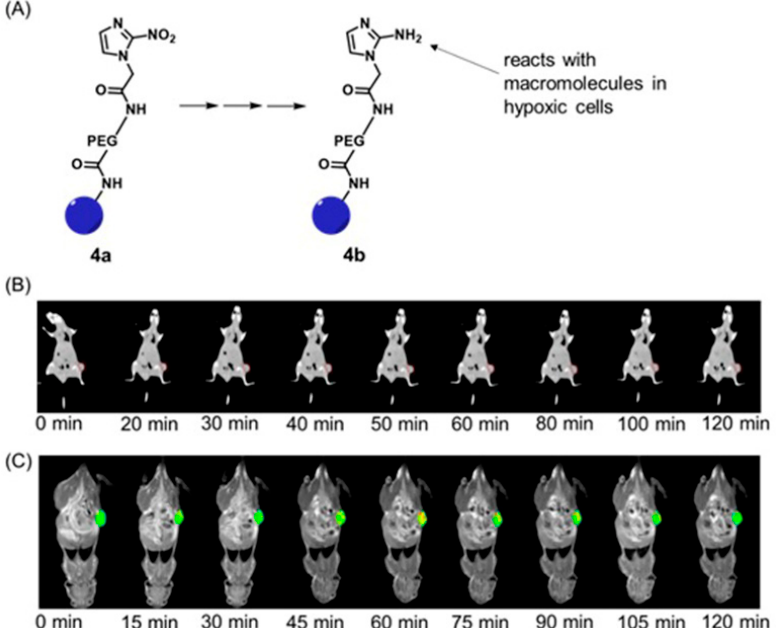
Figure 9. ( A ) Schematic illustration of the reduction in the nanohybrid for dual-mode MRI–X-ray CT imaging. Blue circles represent dendrimer nanohybrid. The nanohybrid accumulates in tumors is reduced in hypoxic cells and binds with biomacromolecules. ( B ) In vivo X-ray CT images of the hypoxic tumor at different time points post intravenous injection of the nanohybrid. The red dashed circle in each panel indicates the tumor site. The tumor site has the highest X-ray CT intensity at 60 min, and then the intensity starts to decrease gradually. ( C ) In vivo T 1 -weighted MRI images of the hypoxic tumor at different time points post intravenous injection of the nanohybrid. The tumor site has the highest MRI intensity at 60 min, and then the intensity starts to decrease gradually. Adapted